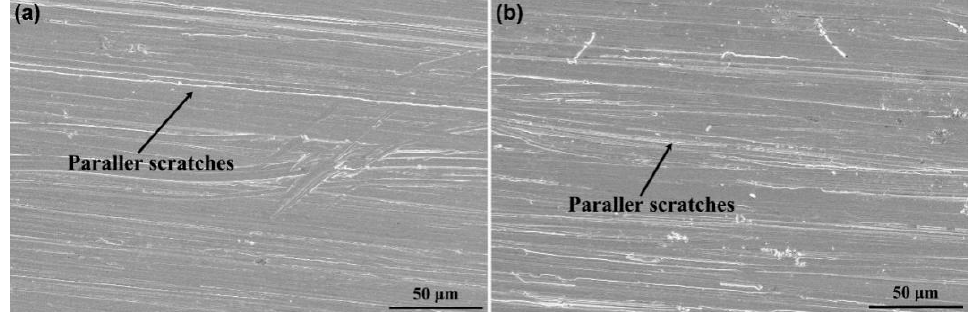
Figure 15. SEM wear morphologies of samples ( a ) BA-2 and ( b ) NA-2 after sliding abrasion.